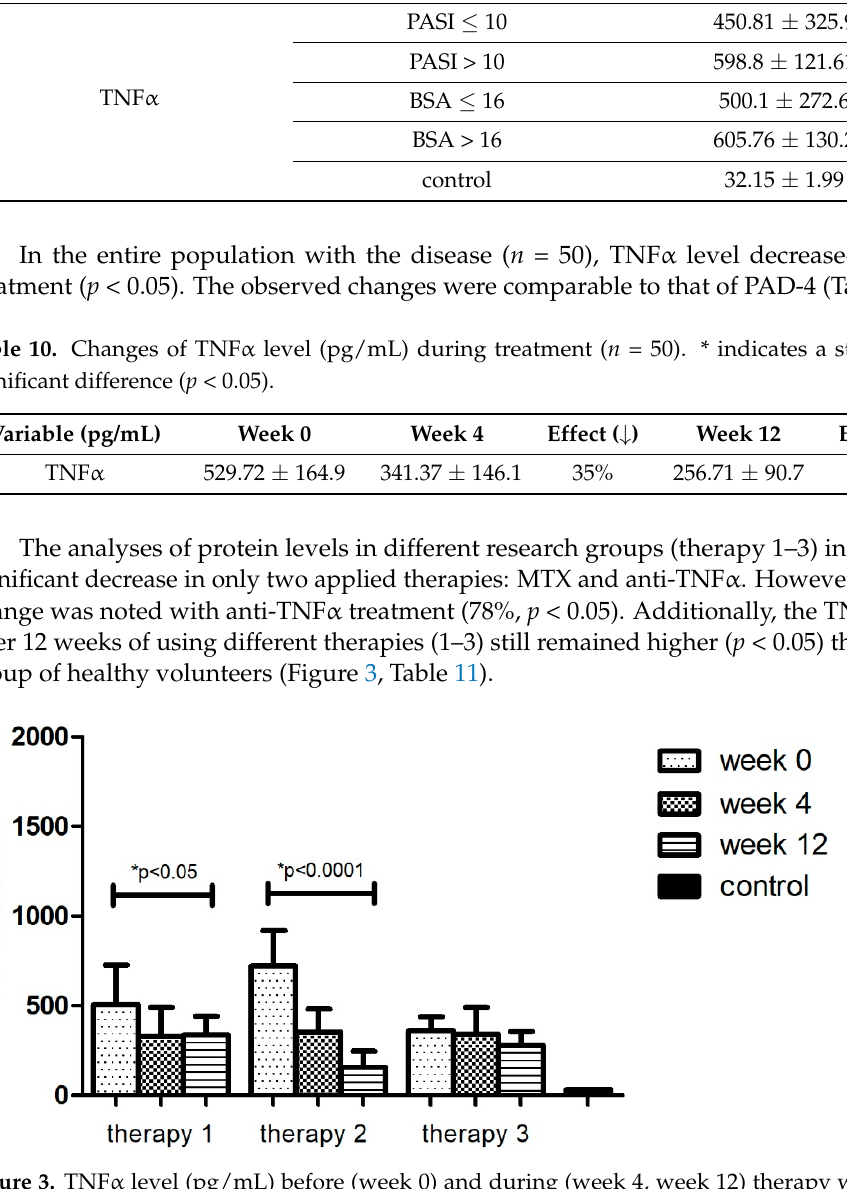
Table 9. Pre-treatment levels of PAD-4 (pg/mL) in patients with plaque psoriasis ( n = 50) with PASI score ≤ 10 ( n = 12), PASI > 10 ( n = 38), BSA ≤ 16 ( n = 12), BSA > 16 ( n = 38) and in the control group ( n = 16).